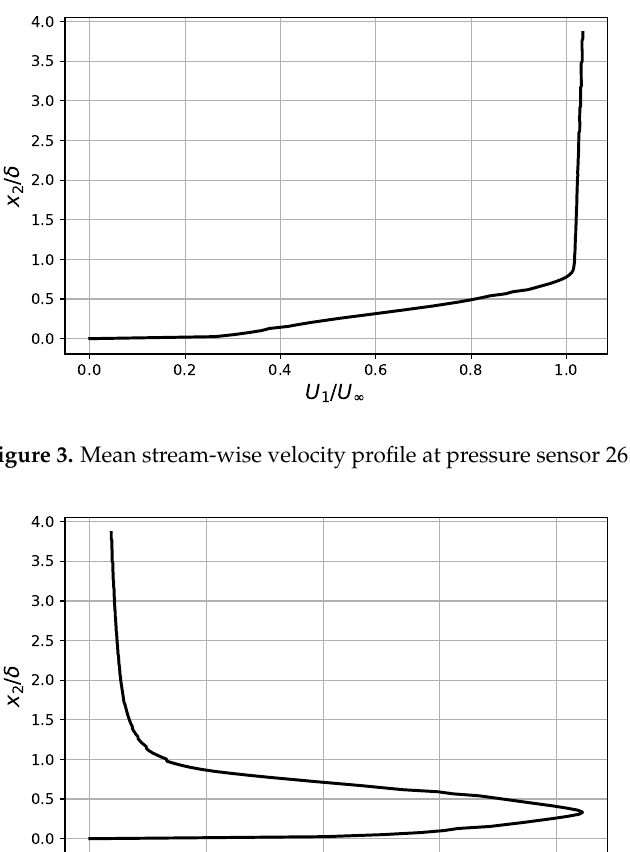
Figure 2. Positions of the mesh layers on which the correlation coefficients have been computed, courtesy of ISAE-Supaero. The black circle indicates the position of pressure sensor number 26 in the experimental setup.